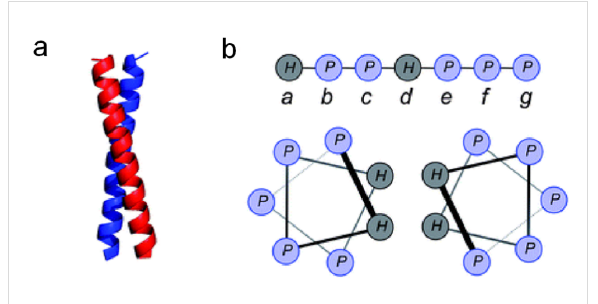
Figure 6: Figure showing ( a ) a coiled coil motif due to hydrophobic interactions between hydrophobic amino acids in the individual helices. ( b ) Helical-wheel diagram showing how the hydrophobic amino acids situated on the a and d sites can interact with each other to form the coiled coil